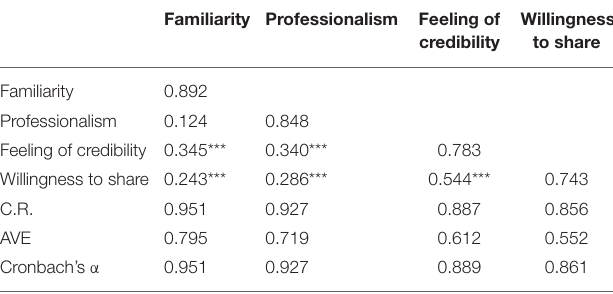
TABLE 3 | Differential validity analysis and variable correlation